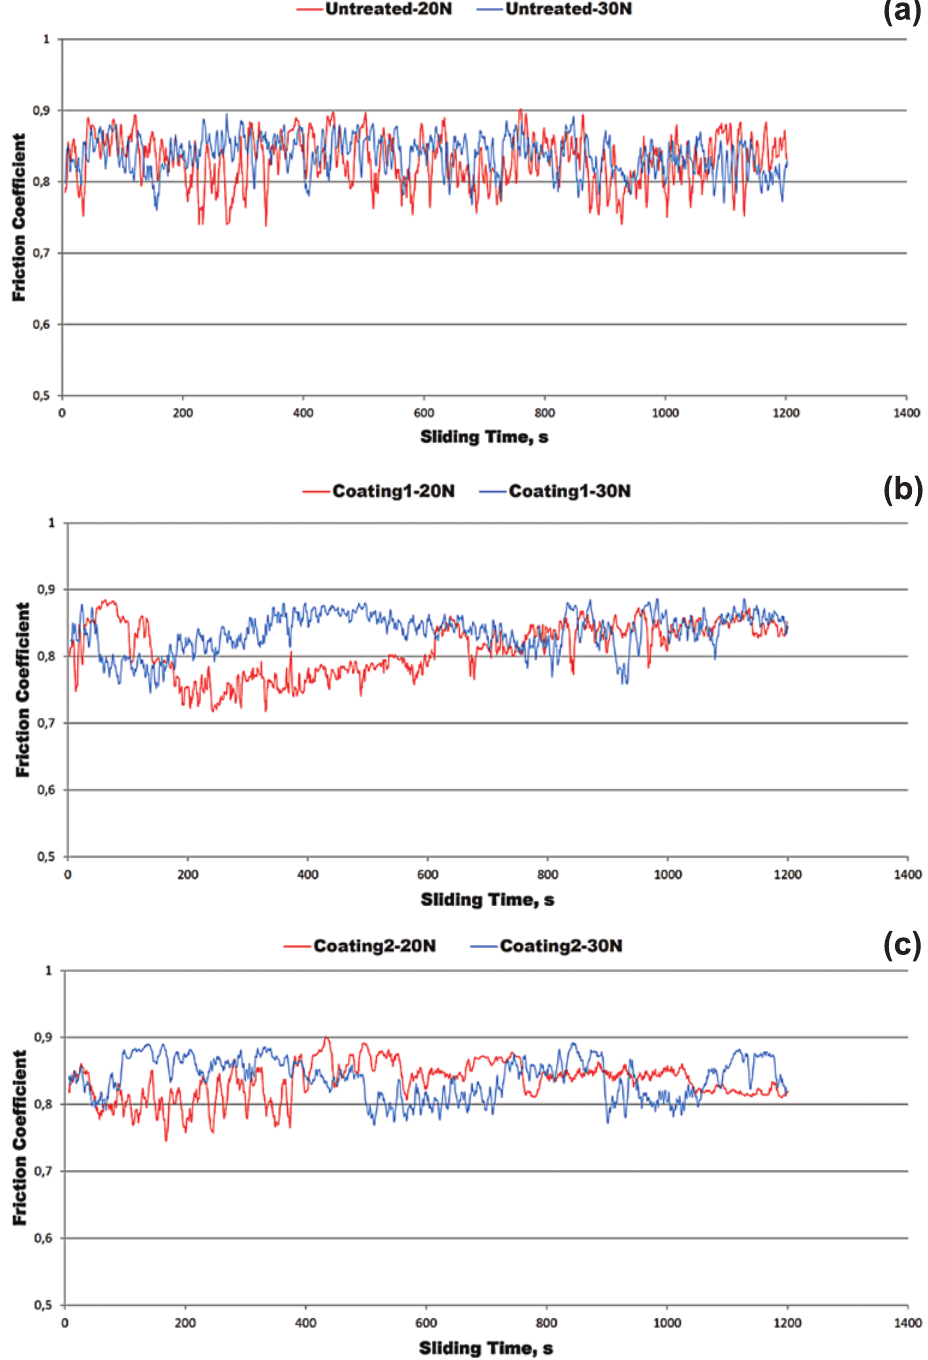
Fig. 4: The friction coefficient curves: (a) uncoated, (b) Coating1, (c)